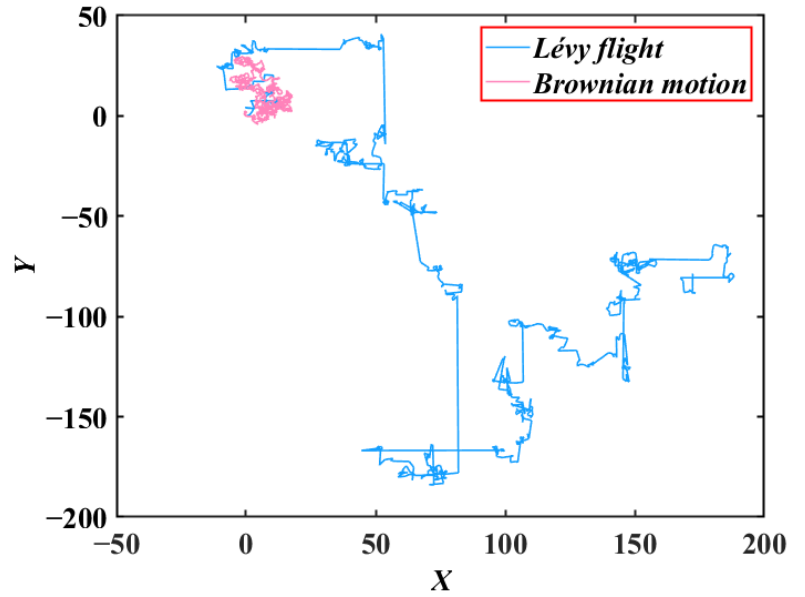
Figure 8. Lévy flight and Brownian motion. Figure 8. L é vy flight and Brownian